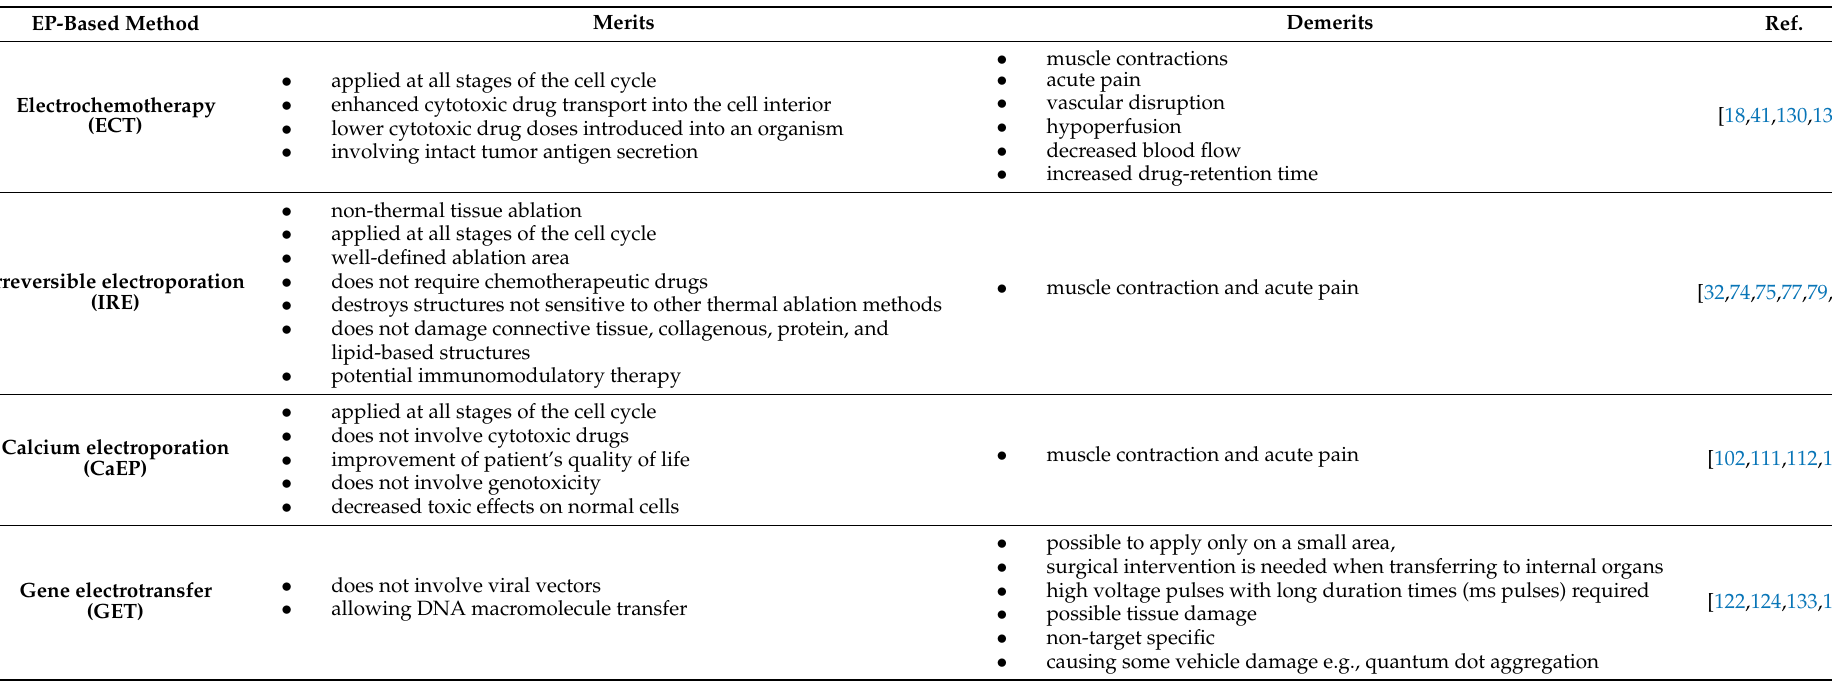
Table 1. Summarized merits and demerits of electroporation-based treatment